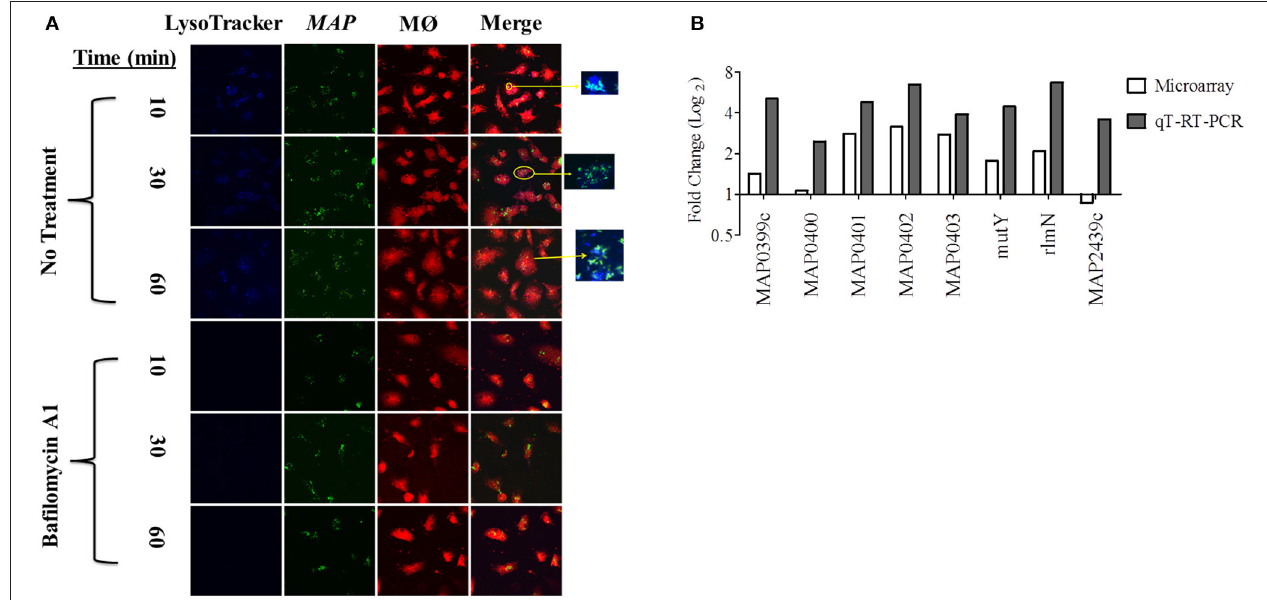
FIGURE 1 | An acid stress network corresponds with phagosome maturation in MDMs. (A) MDMs were infected with MAP K-10 (pWes4) GFP and analyzed for phagosome acidification at 10, 30, and 60min post-infection using LysoTracker Blue (above panel). Phagosome acidification was observed at 10–60min. Acidification was validated by bafilomycin A1 inhibition of vascular ATPases (below panel). (B) Microarray analysis comparing MAP K-10 infected MDMs treated with and without bafilomycin A1 treatment at 30min identified an acid stress related network. MAP0403 , a predicted serine protease, was the central node of the network. All genes within the acid stress network were validated by